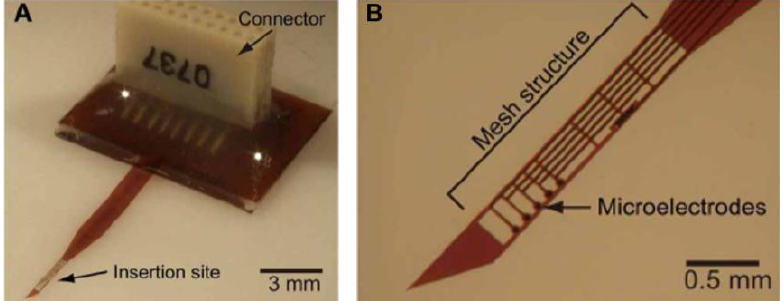
Figure 7. Example of a packaging solution for a polyimide intracortical probe. ( A ) Plastic plate bonded to backside of polyimide with epoxy to reinforce base during multiple reconnections. Omnetics connector soldered to gold pads and epoxy used as insulation. ( B ) Magnified view of polyimide- based, mesh, intracortical probe. Reproduced with permission from Creative Commons open access policy from [158].